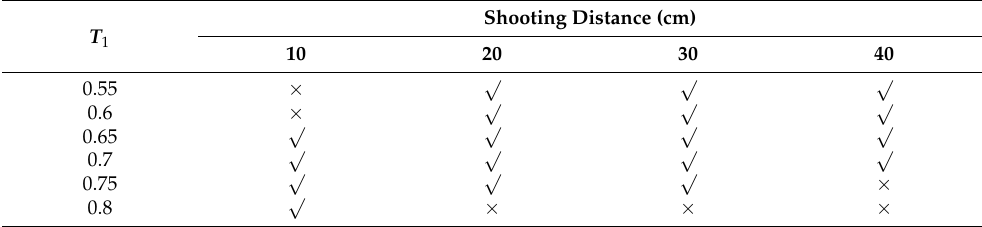
Table 1. Resynchronizing Result of se with 5 × 5